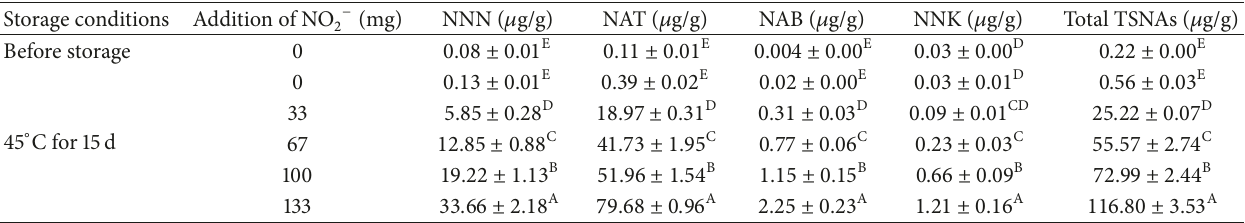
Note . Each value represents the mean of three independent samples, and uppercase letters indicate significant differences between the treatments at 𝑃 < 0.05 .